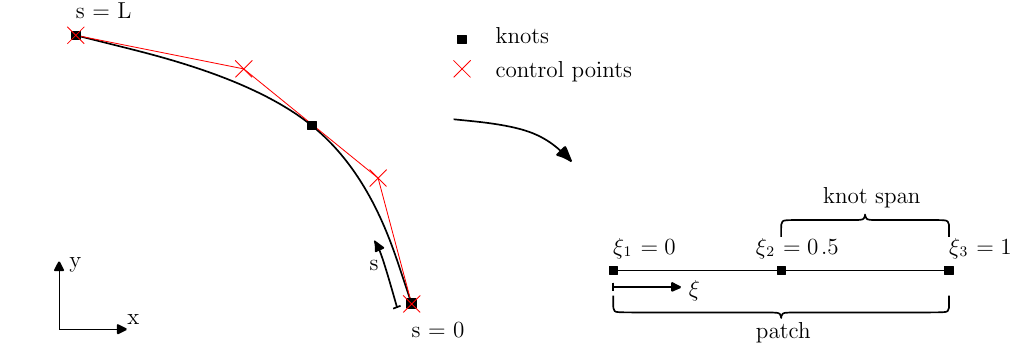
Figure 1. Description of NURBS geometry.